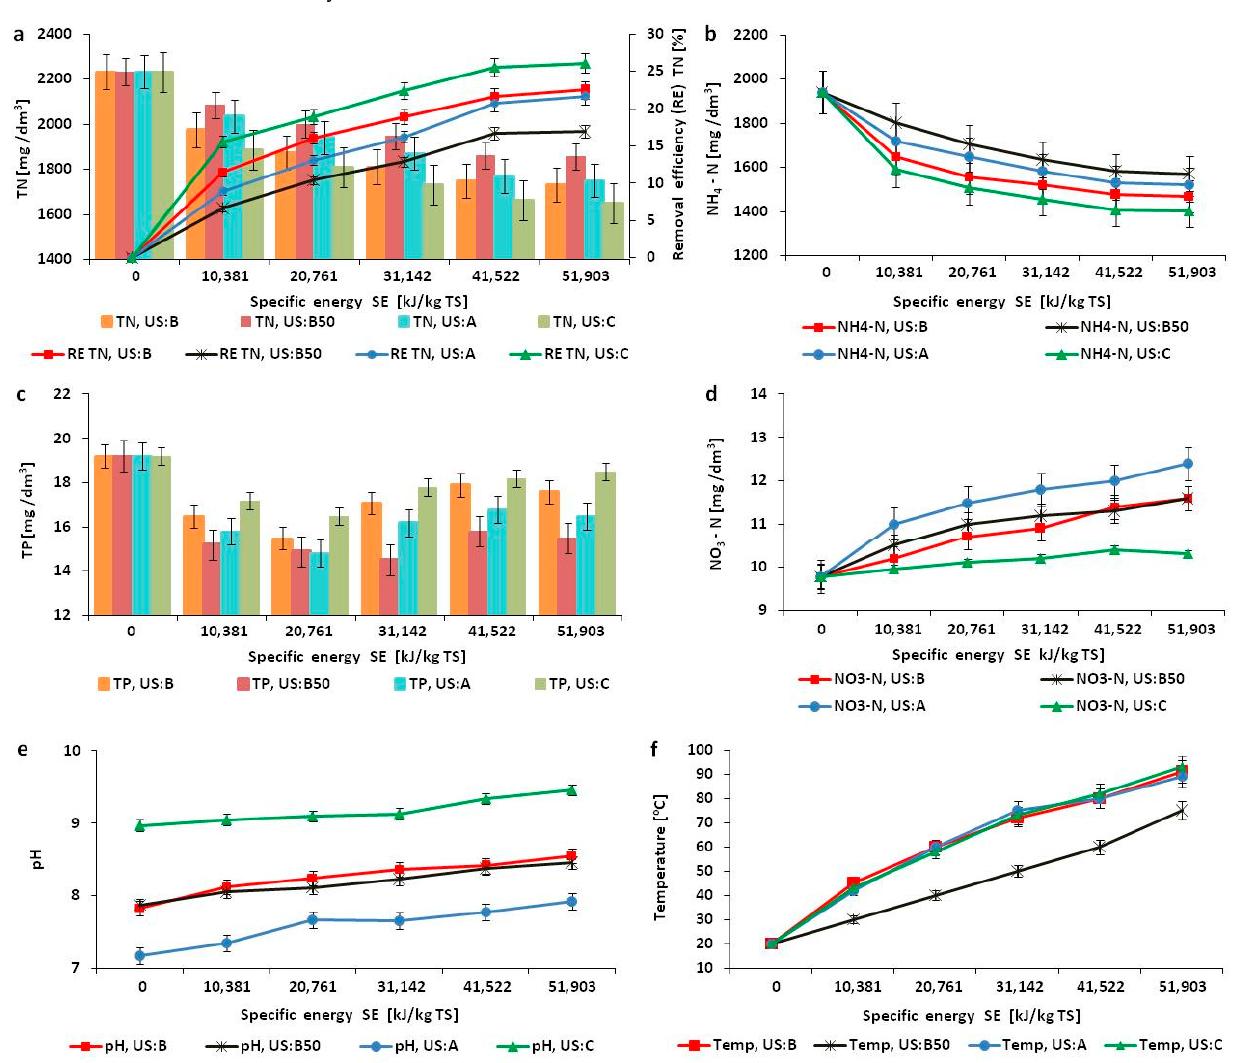
Figure 4. Removal efficiency of TN ( a ); concentration of TN ( a ), NH 4 –N ( b ), TP ( c ) and NO 3 –N ( d ); pH value ( e ); temperature ( f ) depending on specific energy and initial pH during ultrasonication of digestate liquid fraction.